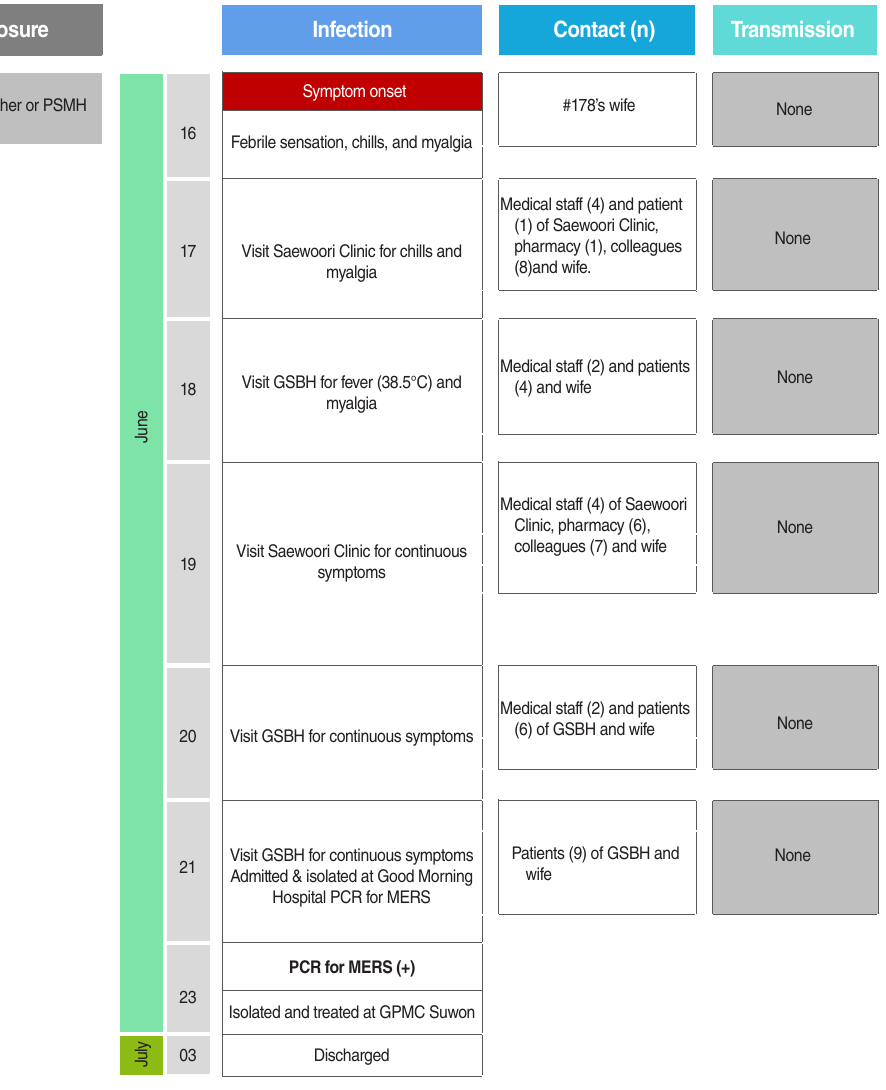
Figure 1. Main events by date for the 178th MERS case in Korea. MERS, Middle East Respiratory Syndrome; PSMH, Pyeongtaek St. Mary’s Hospital; GSBH, Good Samaritan Bagae Hospital; PCR, polymerase chain reaction; GPMC Suwon, Gyeonggi Provincial Medical Center Suwon Hospital.